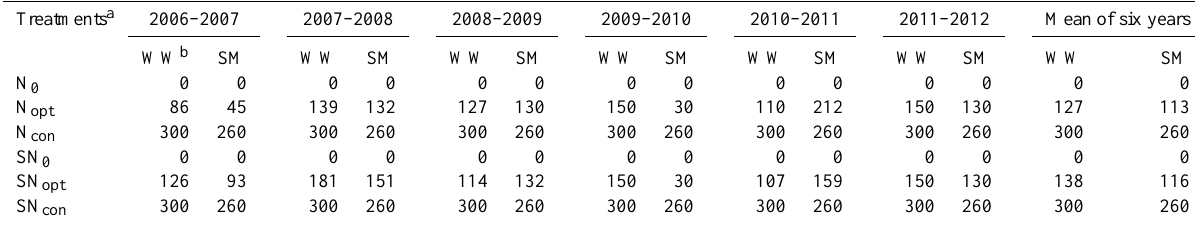
Table 2. Fertilizer N rates (kg Nha − 1 ) in the winter wheat–summer maize cropping system from October 2006 to September 2012. Treatments a